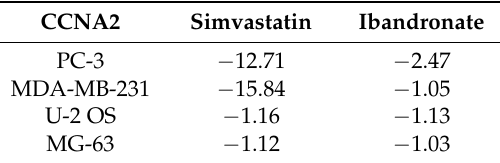
Table 2. Fold downregulation of cyclin A2 ( CCNA2 ).